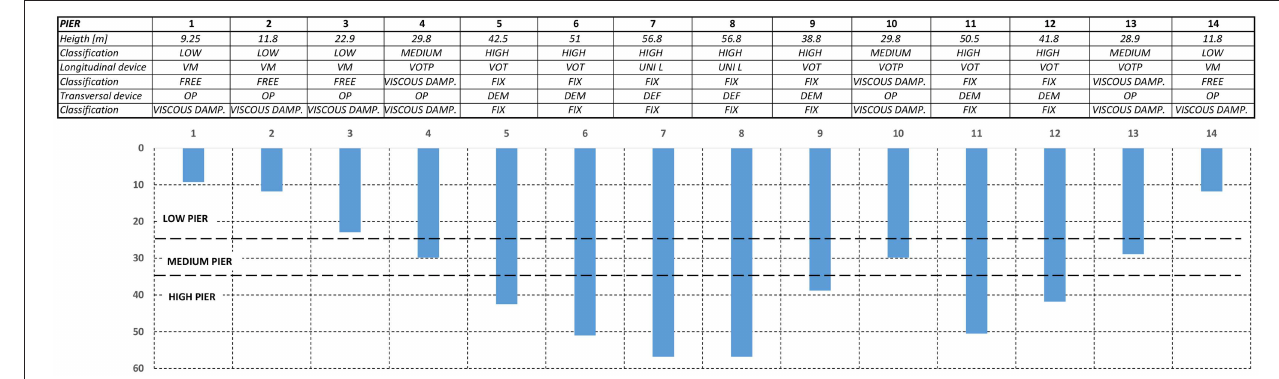
FIGURE 3 | Classification of piers.